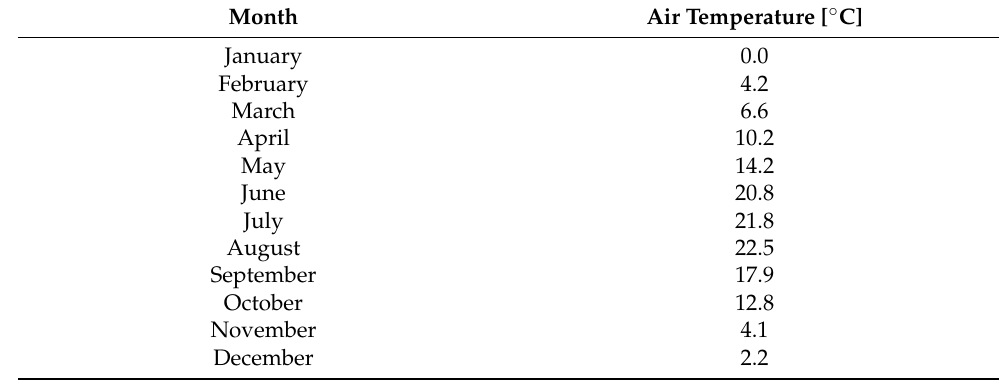
Table 3. Average monthly atmospheric air temperatures in individual months in the Bacau County.